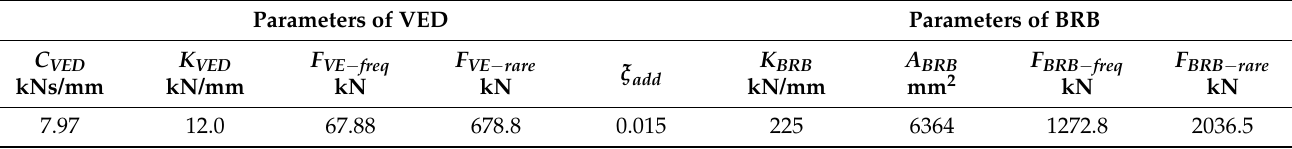
Table 6. Design parameters of VBRB.